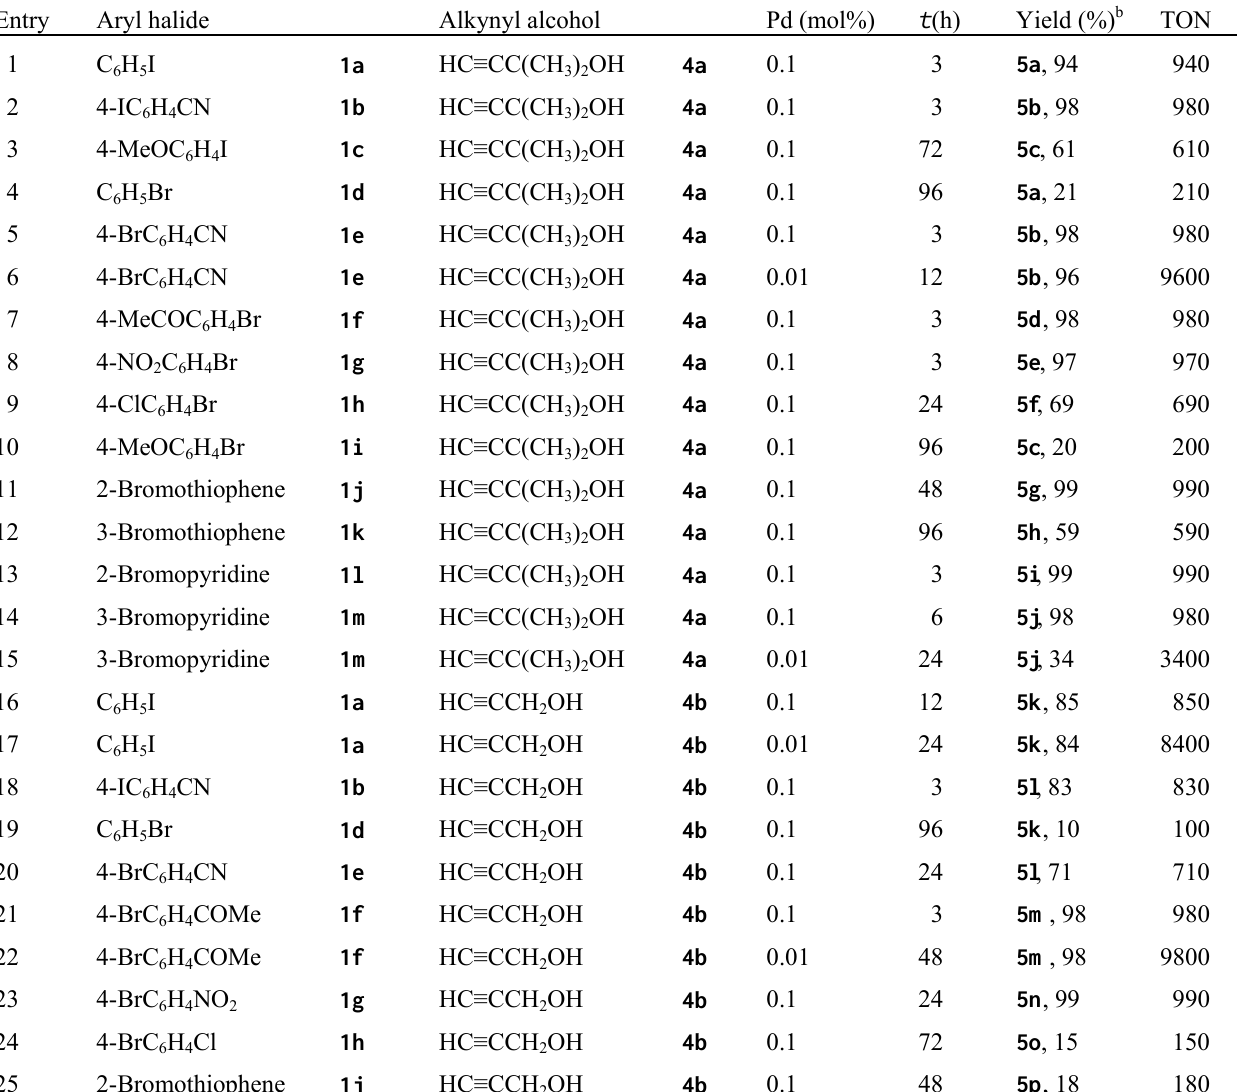
Table 3. Sonogashira reaction of aryl halides 1 with alkynols 4 catalyzed by nanosized MCM-41-Pd.